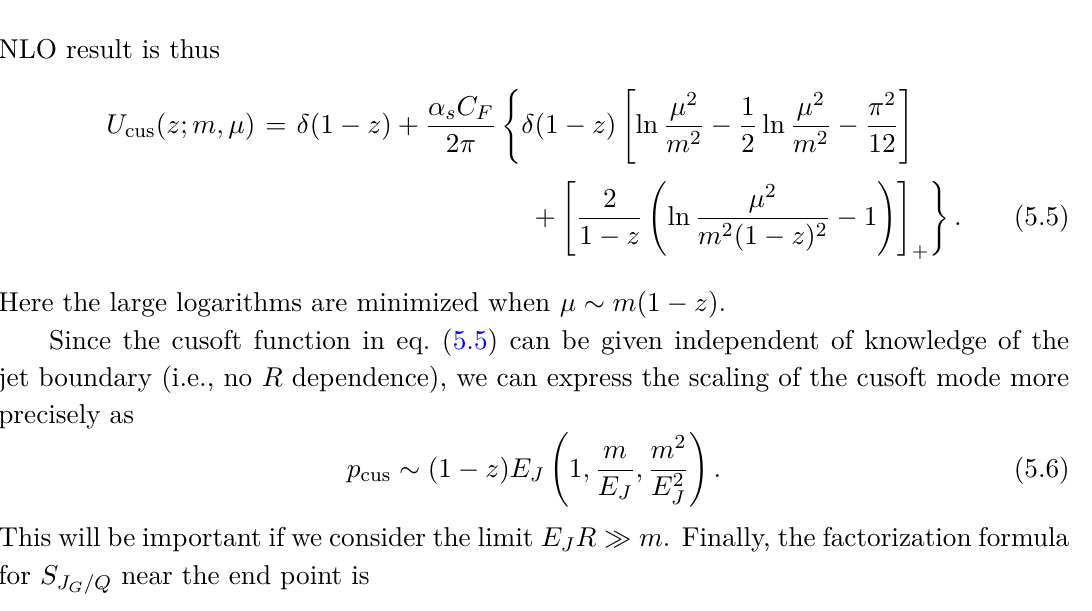
Figure 8 . FFJ and FFGJ for (a) bottom and (b) top quark jets near threshold, with no separation between jet scale and heavy quark mass, i.e., E J R ∼ m . The black curves are FFJs and the b ( t ) blue curves are FFGJs, with z cut = 0 . 1 , R = 0 . 4 , and µ min = 0 . 5 GeV for the both solid black and solid blue curves (ref. appendix B for the definition µ min in profile functions). In panel (a), the dashed curve corresponds to µ min = 0 . 4 GeV in the profile function for the ultrasoft scale µ us , and the dotted curve corresponds to µ min = 0 . 3 GeV. Note that for the top quark jet, the groomed FFJ is insensitive to the exact value of µ min